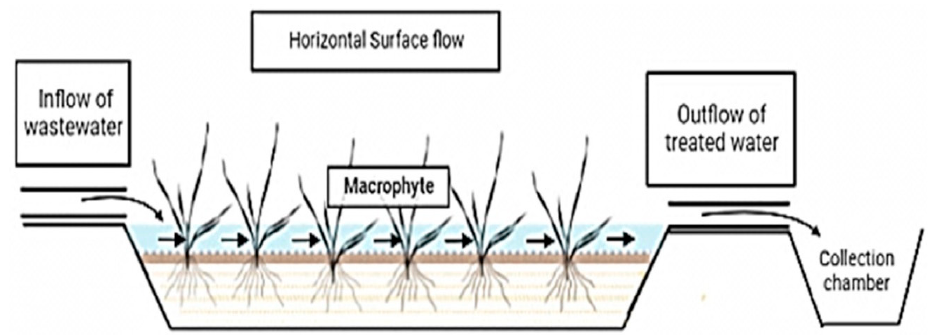
Figure 2. Surface flow ‐ constructed wetland.